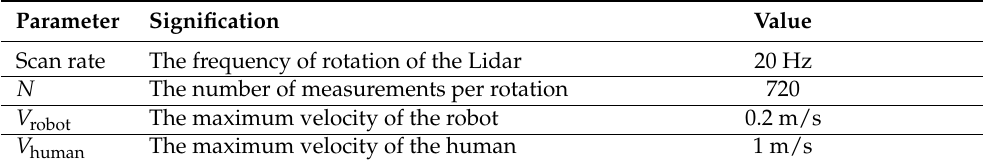
Table 2. Main Parameters of the Simulations.